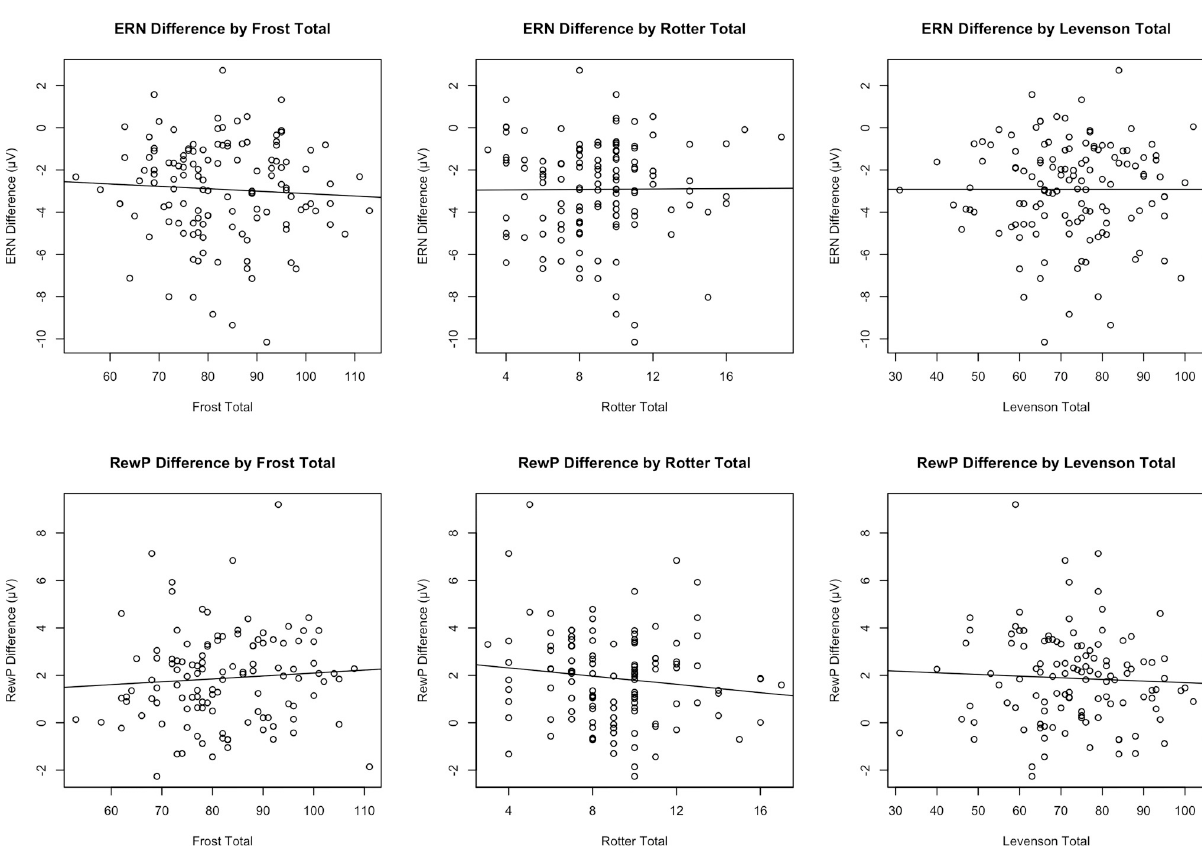
Fig 1. Scatter plots depicting all scales of interest by Δ ERN amplitude or Δ RewP